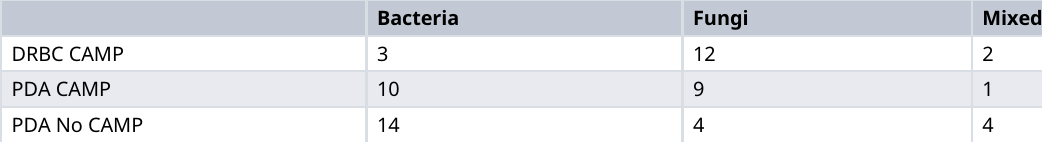
Table 1. Summary of colony forming unit